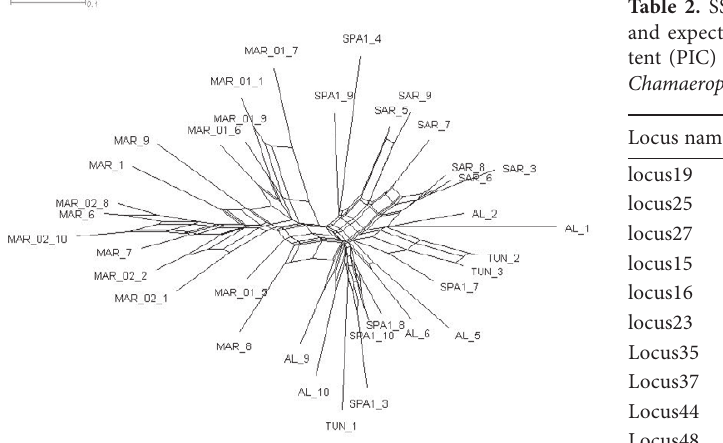
Figure. 5. Split tree of 35 Chamaerops humilis genotypes of five putative populations based on Nei and Li’s genetic distance. MAR: Terketen, Morocco; MAR1: Beni Mellal, Morocco; MAR2: Touama, Morocco; SPA: Valencia, Spain; ALG: Sidi Belattar, Algeria; TUN: Cap Serrat, Tunisia; SAR: Porto Tangone, Sardinia, Italy.